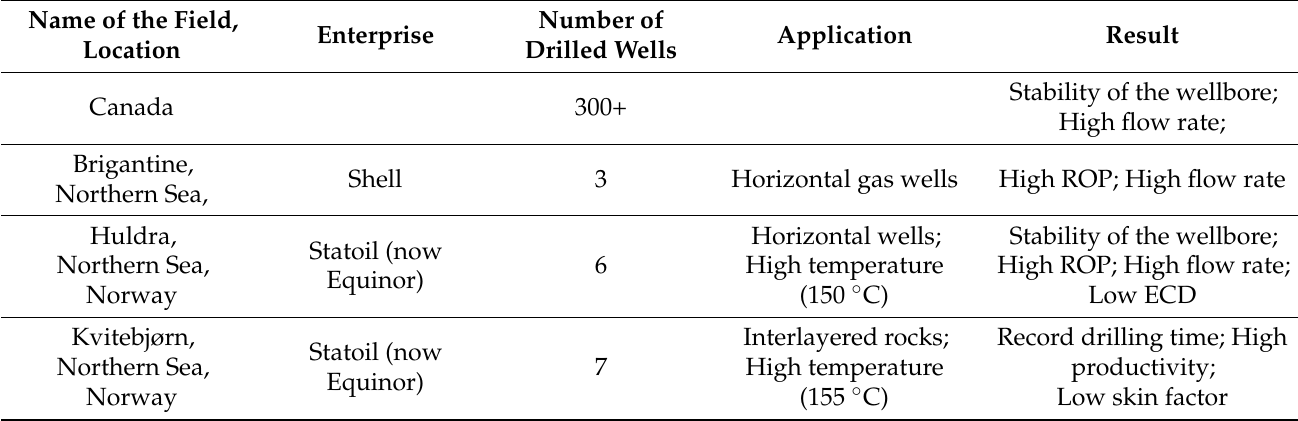
Table 1. Experience in the use of fluids based on